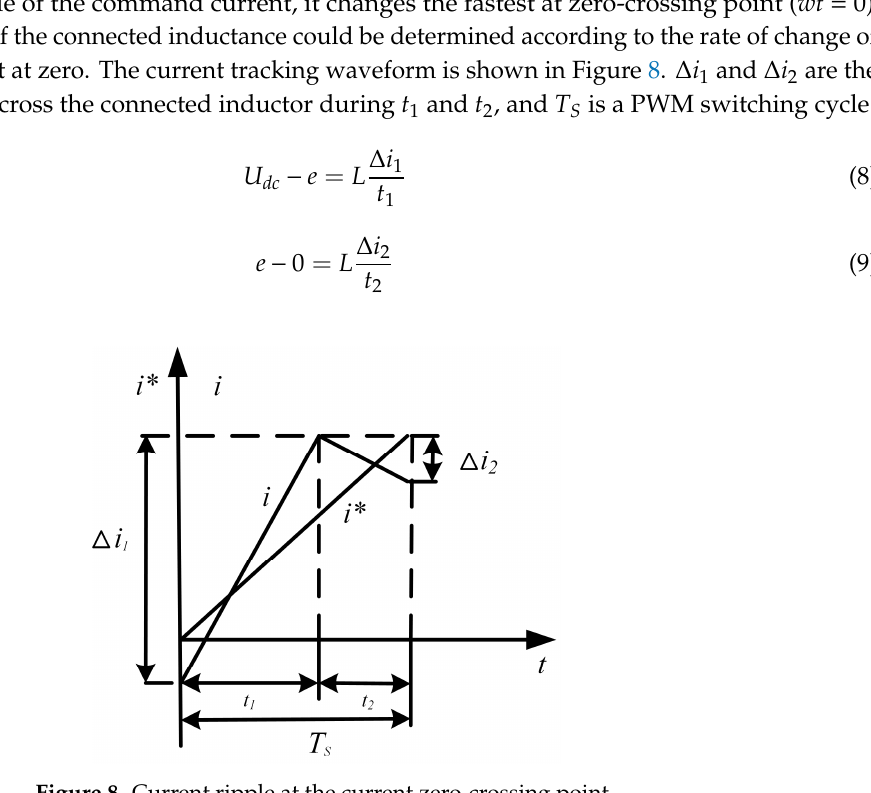
Figure 8. Current ripple at the current zero-crossing point.